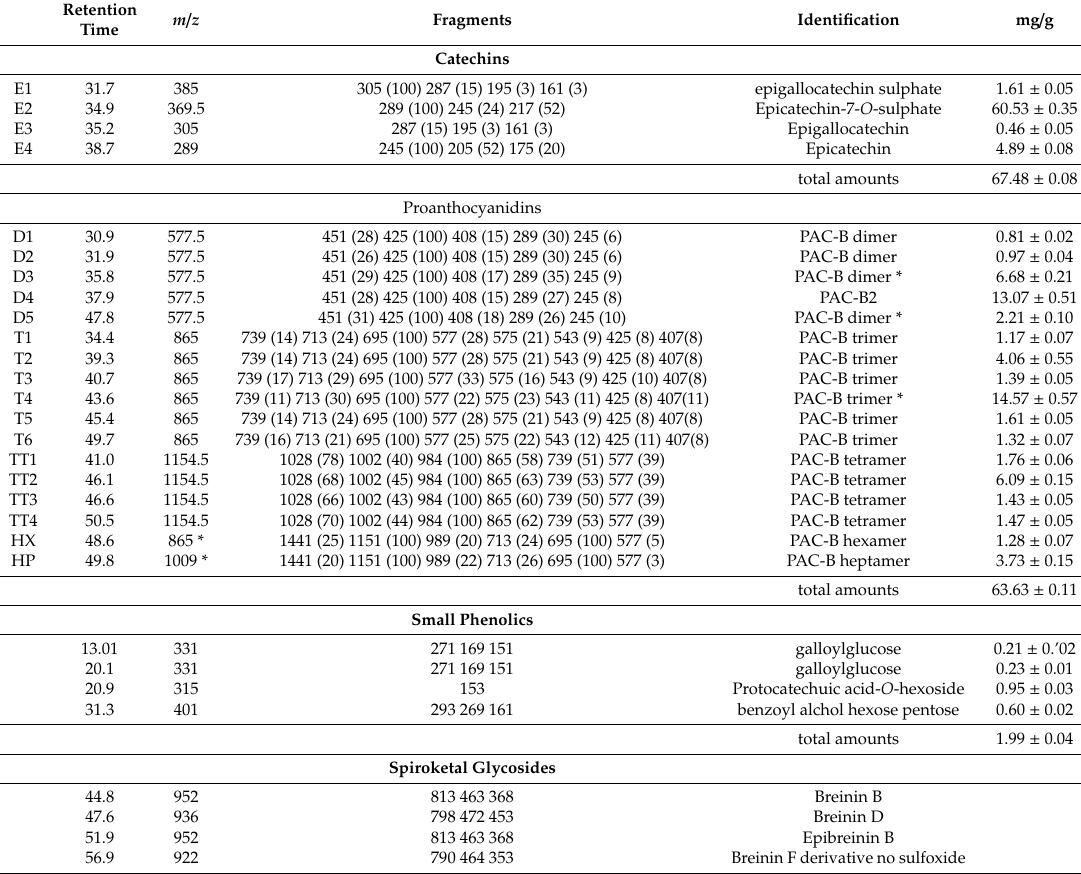
Table 2. Quantification of compound detected by LC-MS in B. retusa stem